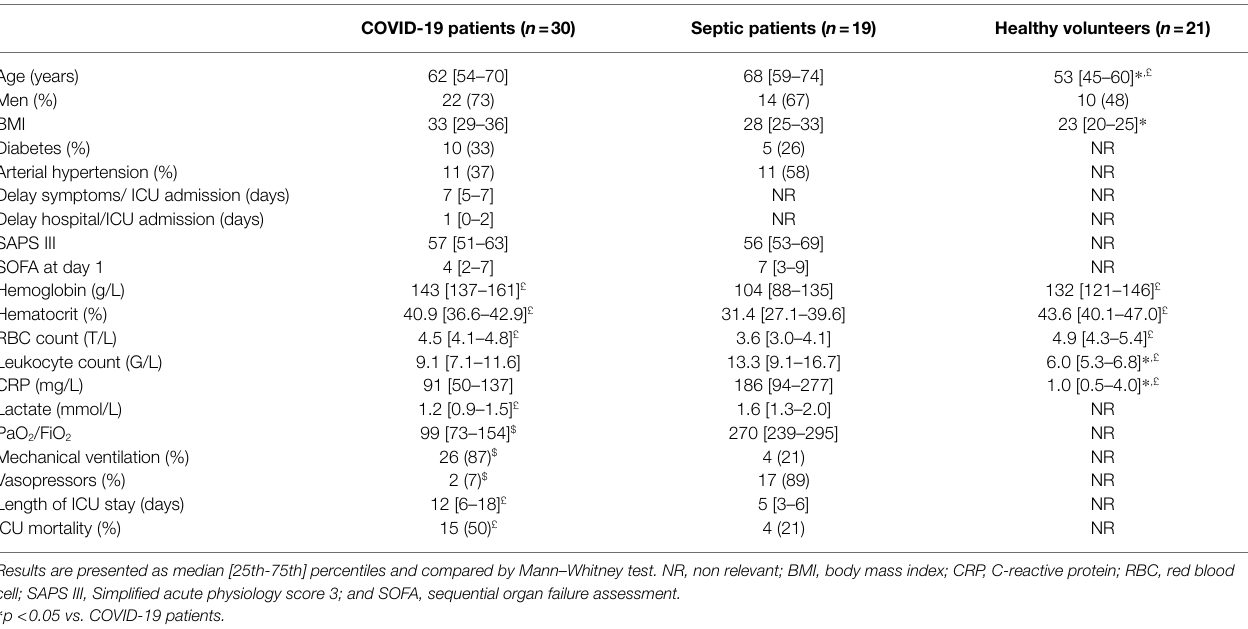
TABLE 1 | Subject demographics, biological characteristics, and